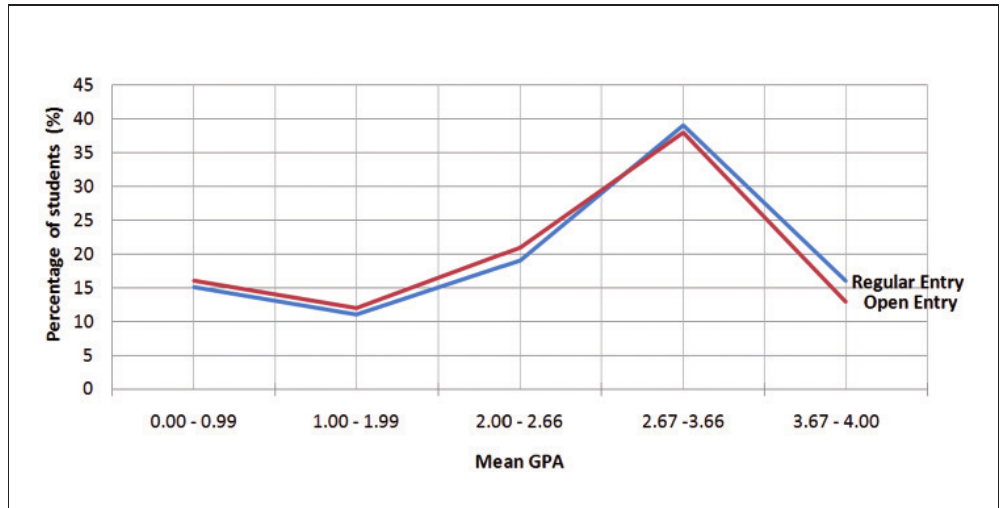
Figure 6 Mean GPA performance of Open Entry and Regular Entry students ( p<0.05 )